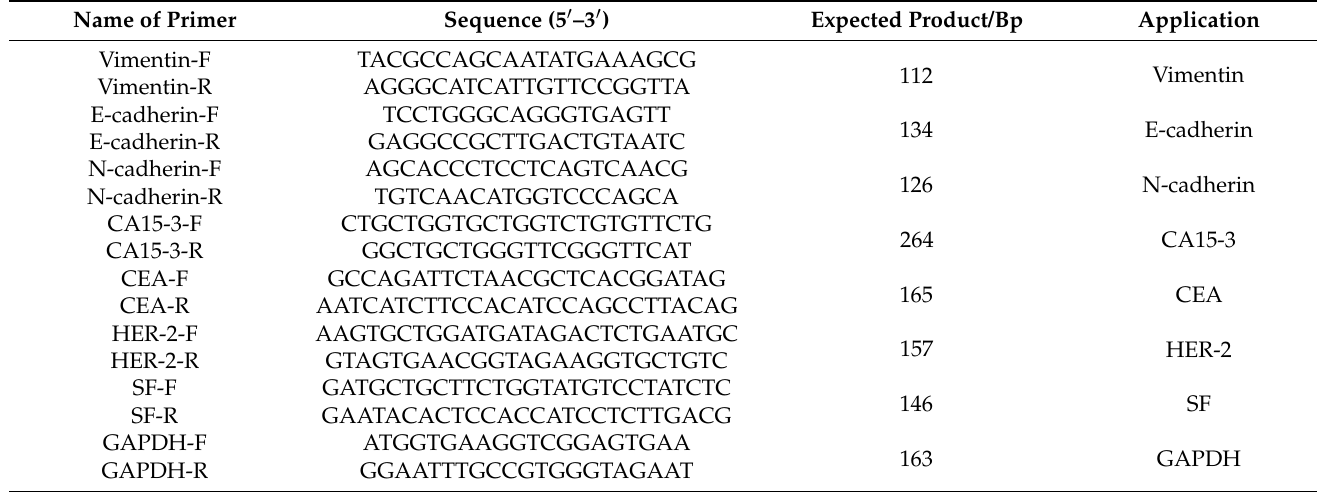
(Table 1). All primers were synthesized by Jilin Kumi Biotechnology Co., Changchun, China. Table 1. Primers used for amplification of target genes in this